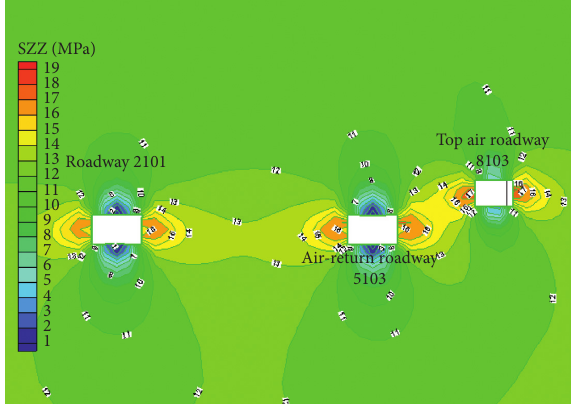
Figure 3: Stress distribution state of surrounding rock of 5103 return air roadway during the excavation of 8103 top return air